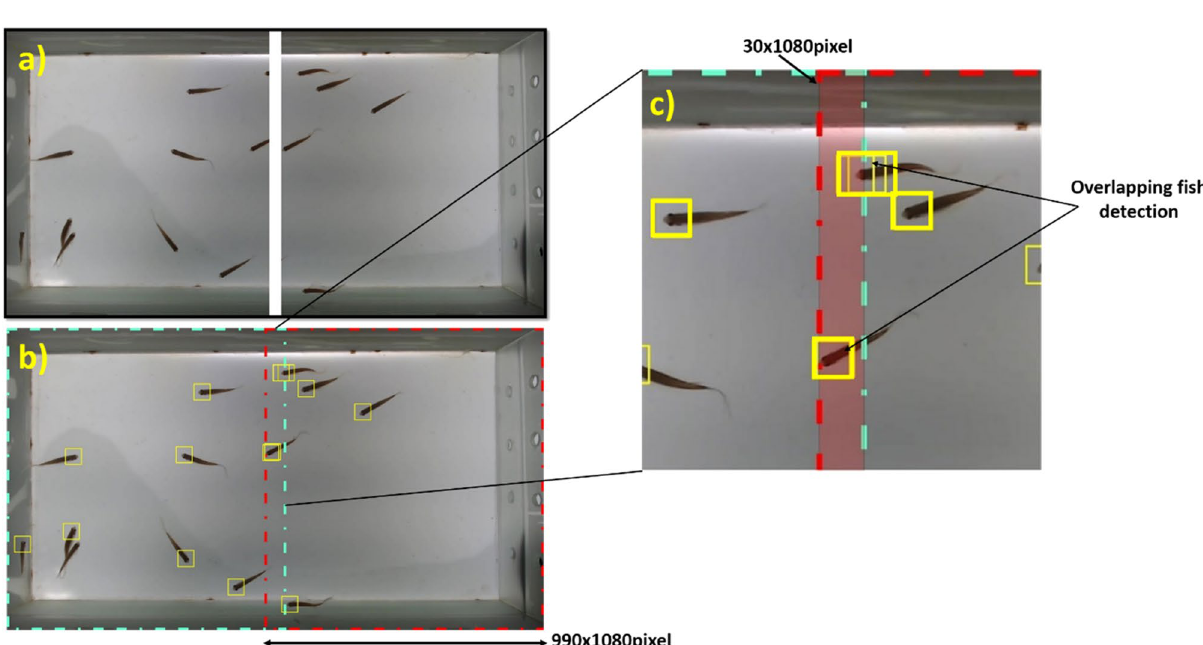
Figure 6. Example of a grid image with overlapping edges and duplication of the delimitation the region of the fish head. (a) Input image for YOLOv2 network divided into grids for the process of fish detection. (b) Assembly of grids with overlapping edges. (c) The red stripes represent the overlapping of the edges of the images during the assembly process (equivalent to 30 pixels wide). Fish were detected in the edge of grids and the correction was made using the grid intersection method presented in Eq.